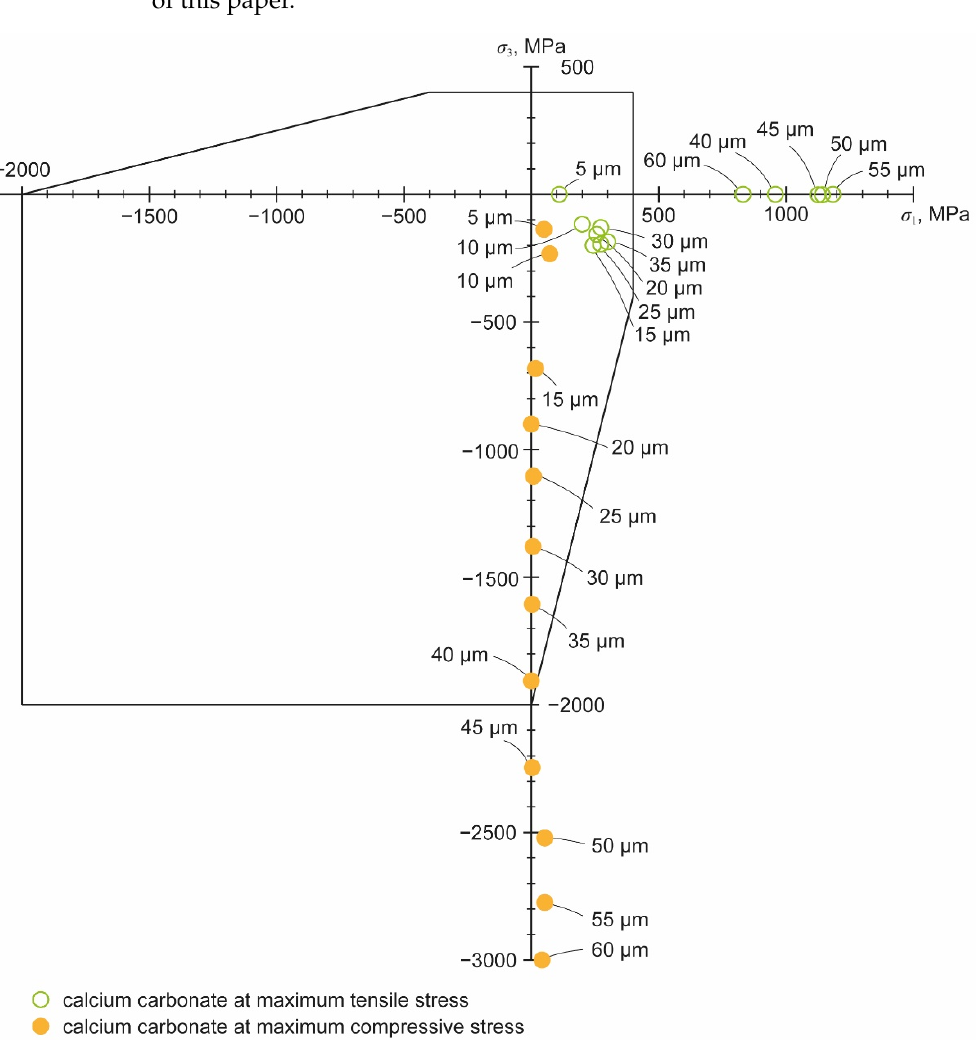
Figure 15. The failure envelope at the impact of calcium carbonate particles with different diameters at an operating pressure of 300 MPa on the surface of a c -axis-aligned sapphire. The values are derived from an explicit dynamic numerical calculation; the two principal stresses for the plane stress state at the times of the highest compressive stress (full dots) and the highest tensile stress (open circles) are shown.